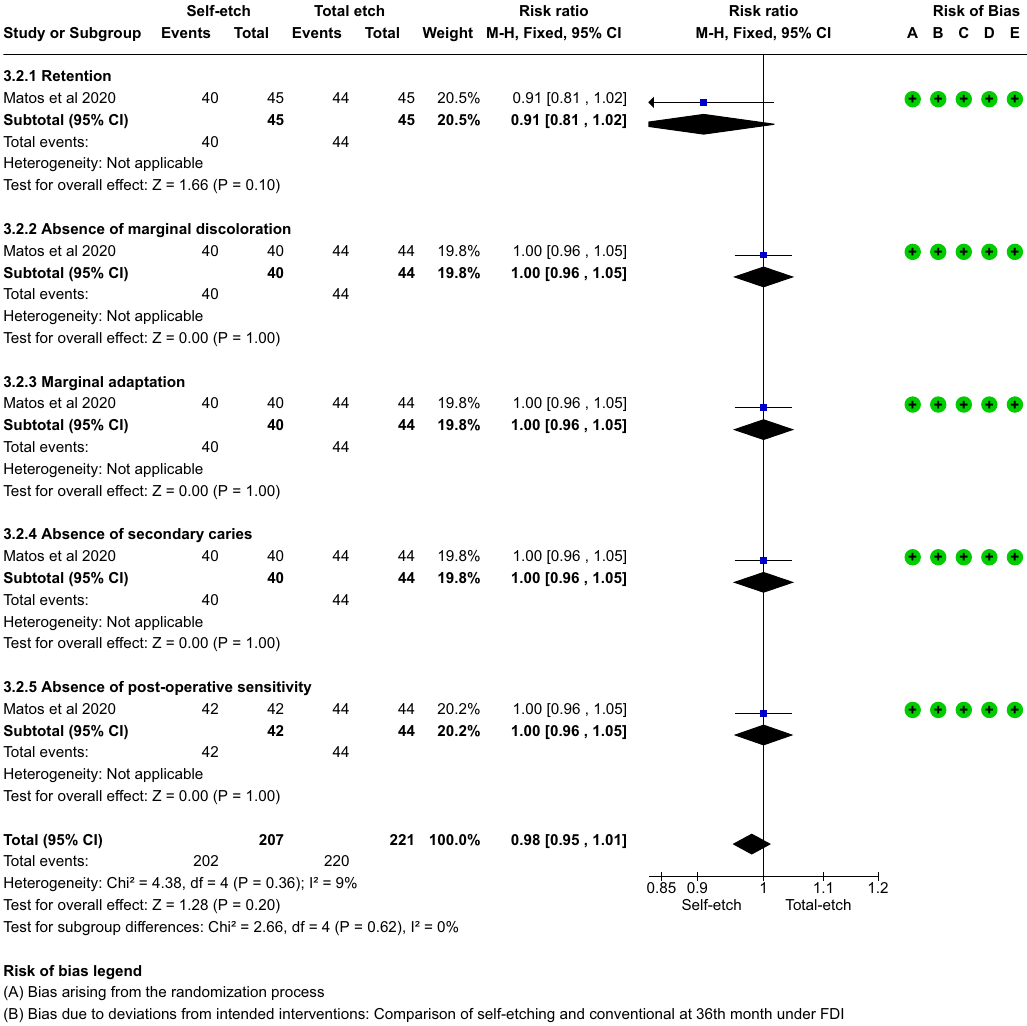
Risk of bias legend (A) Bias arising from the randomization process (B) Bias due to deviations from intended interventions: Comparison of self-etching and conventional at 36th month under FDI (C) Bias due to missing outcome data: Comparison of self-etching and conventional at 36th month under FDI (D) Bias in measurement of the outcome: Comparison of self-etching and conventional at 36th month under FDI (E) Bias in selection of the reported result: Comparison of self-etching and conventional at 36th month under FDI (F) Overall bias: Comparison of self-etching and conventional at 36th month under FDI Fig. 9 Forest plot representing the pooled events at 36 months using FDI criteria. No signi fi cant difference observed between total etch and self-etch adhesive strategies for any of the